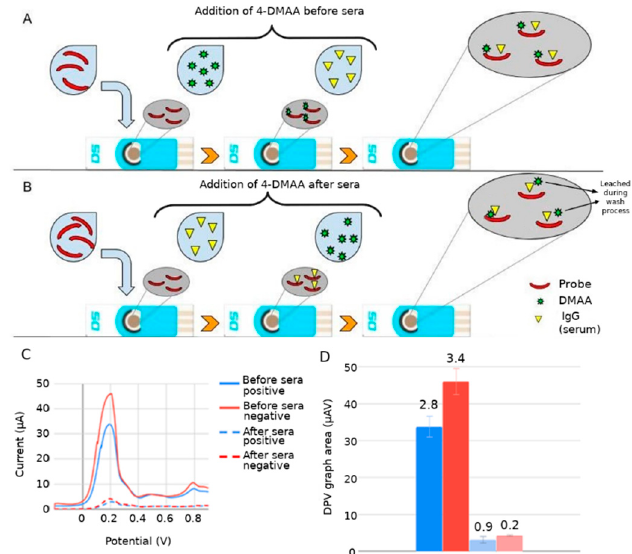
Figure 3. Differential pulse voltammetry (DPV) electrochemical results for the detection of Leishmaniasis using LC1 peptide and 4-DMAA at two different times of functionalization of the electrode surfaces. ( A ) Scheme of functionalization using 4-DMAA before serum; ( B ) scheme of functionalization using 4-DMAA after serum; ( C ) DPV peaks: 45.96 µ A × 0.20 V; 33.73 µ A × 0.19 V; 4.12 µ A × 0.19 V; 2.92 µ A × 0.21 V; and ( D ) DPV graph area (numbers at the top of histogram boxes are standard deviation values). Electrolyte: phosphate-buffered saline solution (pH 7.4).